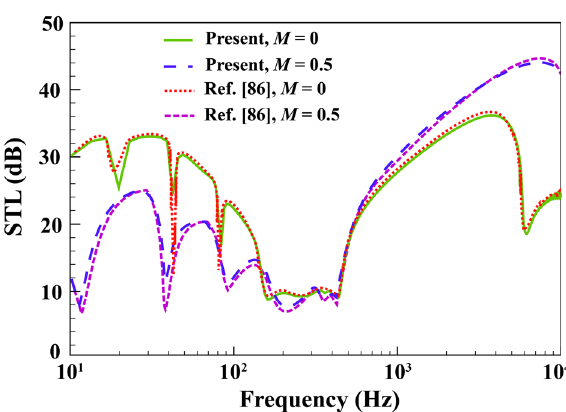
Figure 4. Comparison study of STL curves for single elastic cylindrical